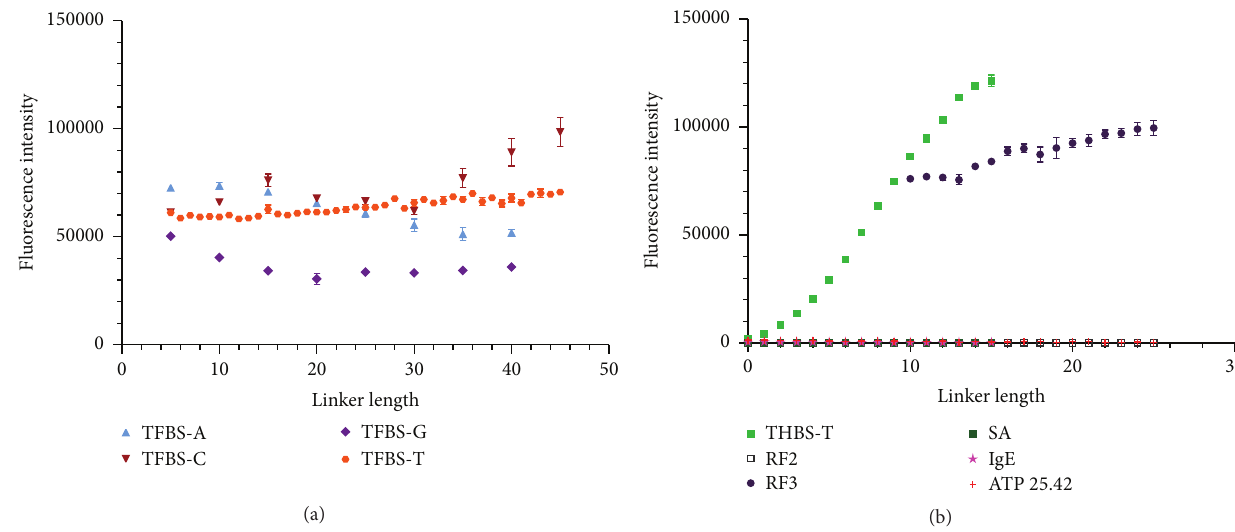
Figure 7: Binding of Cy3-thrombin to various sequences. (a) Binding of Cy3-thrombin to TFBS aptamer using different nucleobase linkers and lengths; (b) Binding of Cy3-thrombin to T linker variants of THBS (thrombin binding sequence and reported G-quartet former), RF2 (riboflavin aptamer and reported G-quartet former), RF3 (riboflavin aptamer and reported G-quartet former), SA (streptavidin aptamer mutant and non-G-quartet former), IgE D17-4 (IgE aptamer and non-G-quartet former), and ATP 25.42 (ATP aptamer initially reported to form G-quartet, but later determined to form pseudoknot structure). Error bars represent SEM of raw fluorescence intensity values for 5–15 replicates of each sequence. Linker identity was T unless otherwise